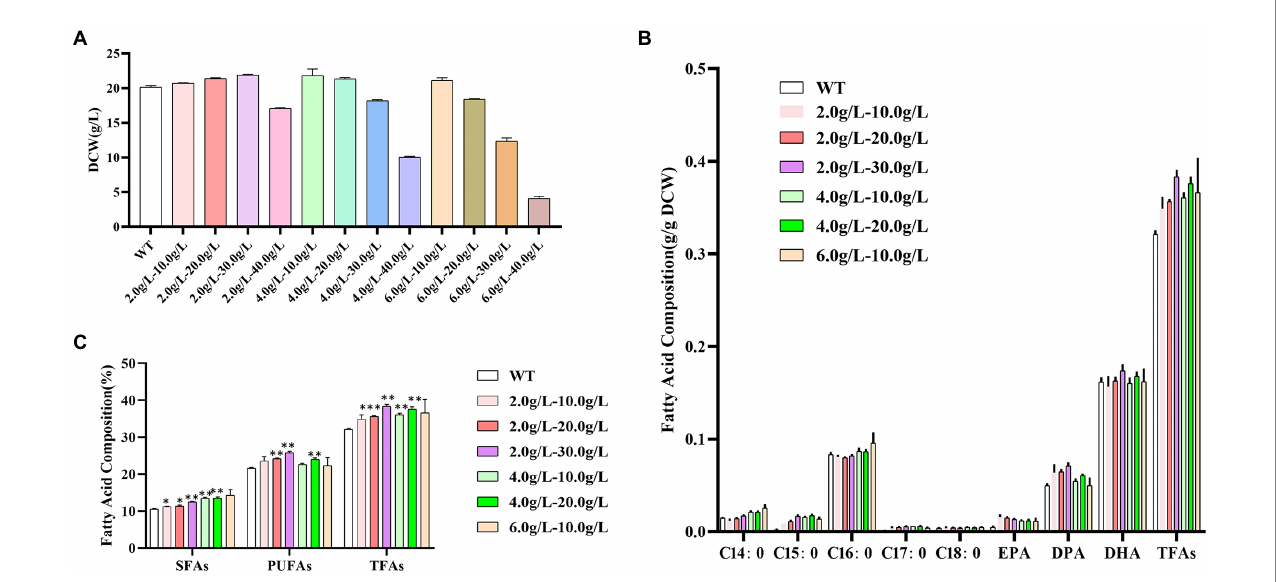
FIGURE 6 Effects of different concentrations of mixed propanol and 1,3-PD on Schizochytrium ATCC 20888. (A) Dry cell weight at 60 h; (B) Fatty acid composition; (C) Composition of saturated fatty acids (SFAs), polyunsaturated fatty acids (PUFAs) and total fatty acids (TFAs). * p -value <0.1, ** p -value <0.05, *** p -value